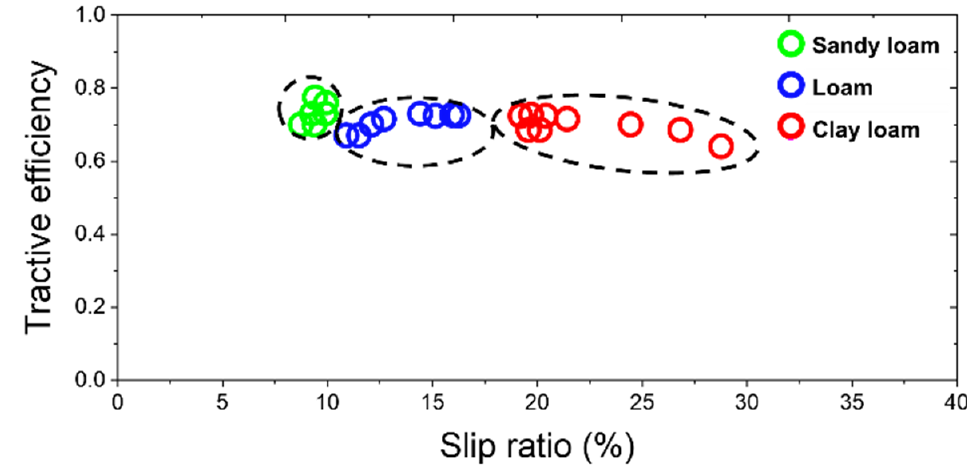
Figure 10. Tractive efficiency by slip ratio and test sites.